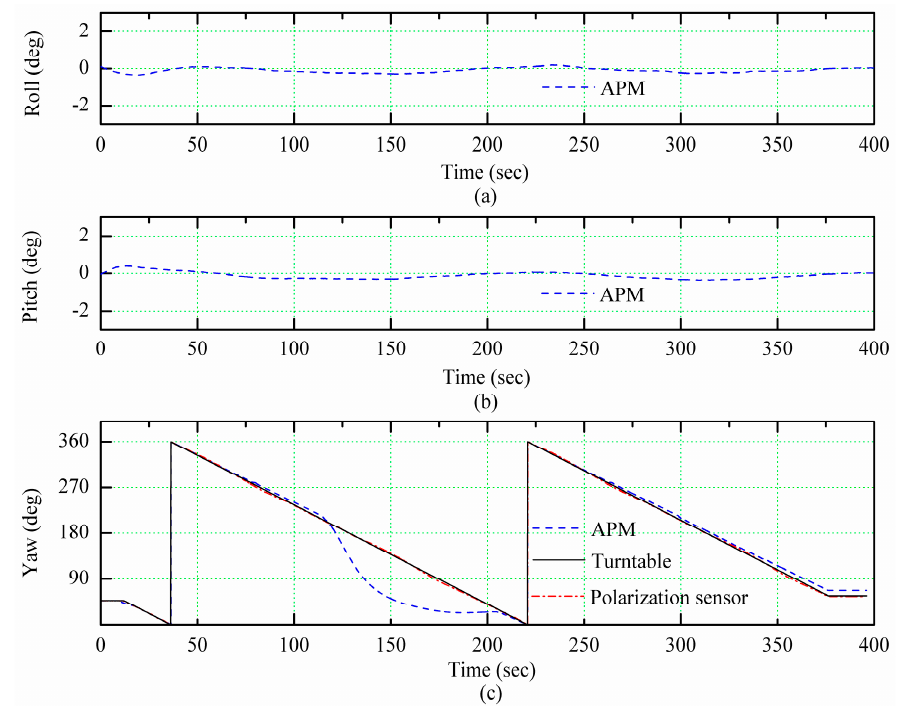
Figure 6. The comparison of attitude angles of polarization sensor and Ardu Pilot Mega (APM). ( a ) Roll, ( b ) Pitch, ( c ) Yaw.